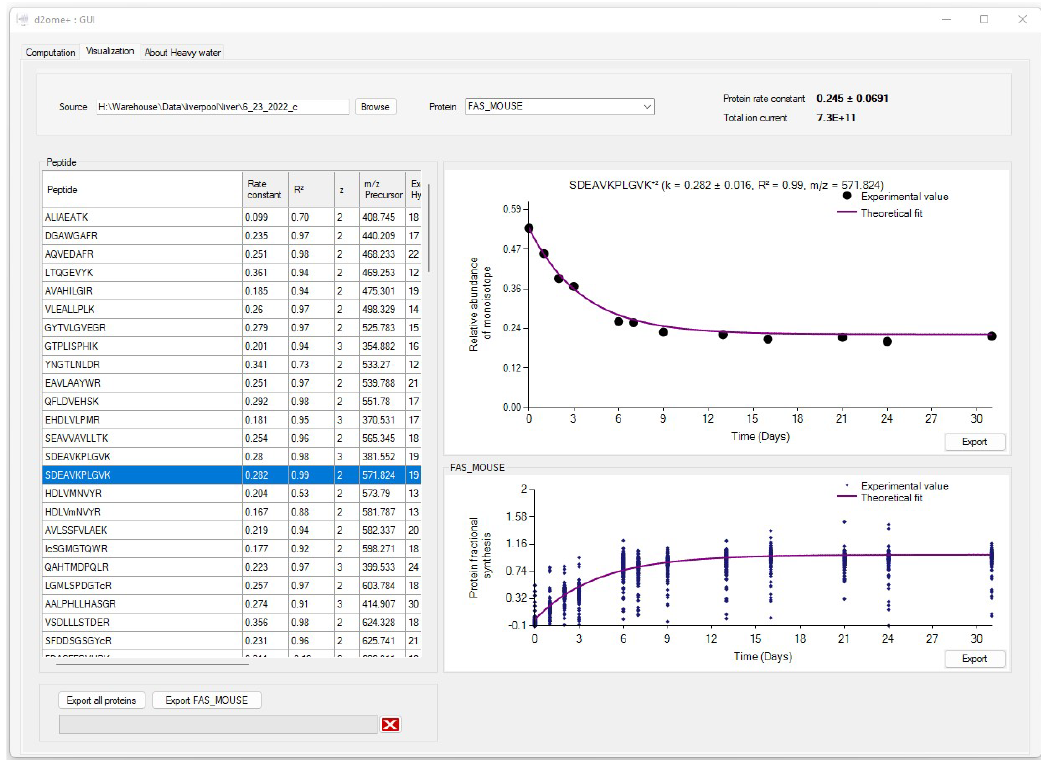
Figure 3. The graphical user interface (GUI) for the results of protein turnover rate estimations. Re- sults for each protein can be accessed by name search. For every peptide of a protein, the experimental time series data and its theoretical fit can be visually examined.